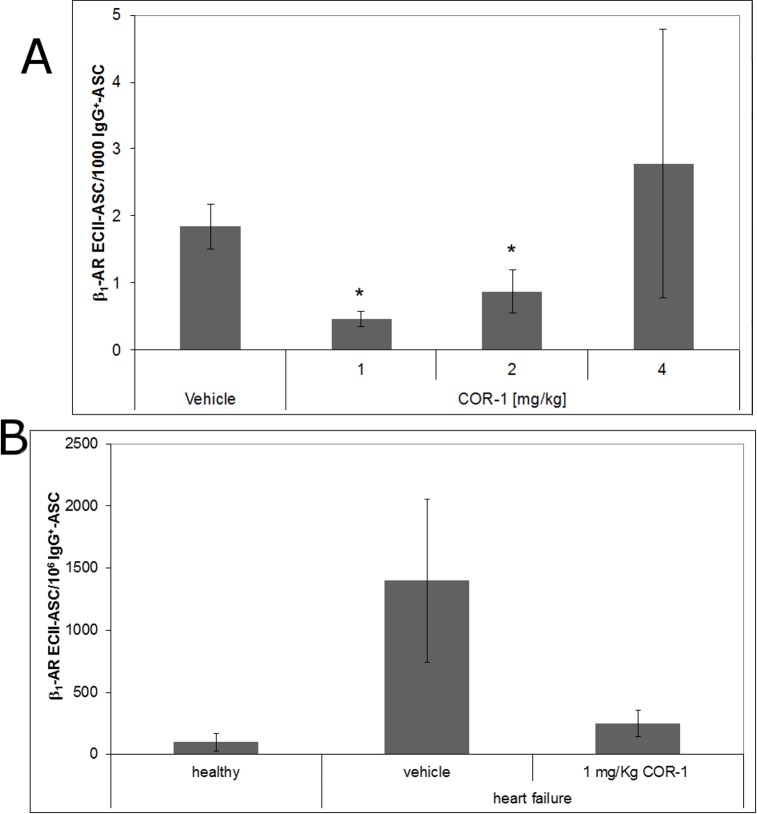
A: Effect of COR-1 on ß1EC2-specific IgG positive B cells of the spleen of HF rats determined by ELISpot analysis (20 month). For ELISpot analysis, spleen cells were prepared from HF rats that had received 10 monthly treat-ments with either vehicle (n = 3), or COR-1 at doses of 1 mg/kg (n = 5), 2 mg/kg (n = 3), and 4 mg/kg (n = 3), respectively. Spleen cells were incubated on plates either coated with IgG, GST, or ß1EC2 fusion proteins, respectively. The relative numbers of ß1EC2-specific IgG positive B cells were determined by subtracting the number of GST specific memory B cells from the number of ß1EC2-specific IgG positive B-cells and subsequent normalization to IgG+ B cells. Means± SEM are shown. N = number of rats analyzed per group. The values for each rat are means of two independent experiments. *p < 0.05 vs. vehicle group. B: Effect of COR-1 on the ß1EC2-specific IgG positive B cells in the spleens of HF rats immunized against GST-ß1EC2 fusion proteins Spleen cells prepared from healthy rats (n = 3) and from HF rats which received 10 monthly treatments with either vehicle (n = 4) or 1 mg/kg COR-1 (n = 4) were blocked with GST, stained with anti-IgG (Fc) and DyL649-labeled GST-ß1EC2 fusion proteins, and then analyzed by FACS. The panel depicts the ratio of specific anti-ß1EC2 IgG-positive cells per 1.000.000 IgG-positive B cells.Due to the large variation in the vehicle group, comparisons with the treatment groups failed to reach statistical significance.